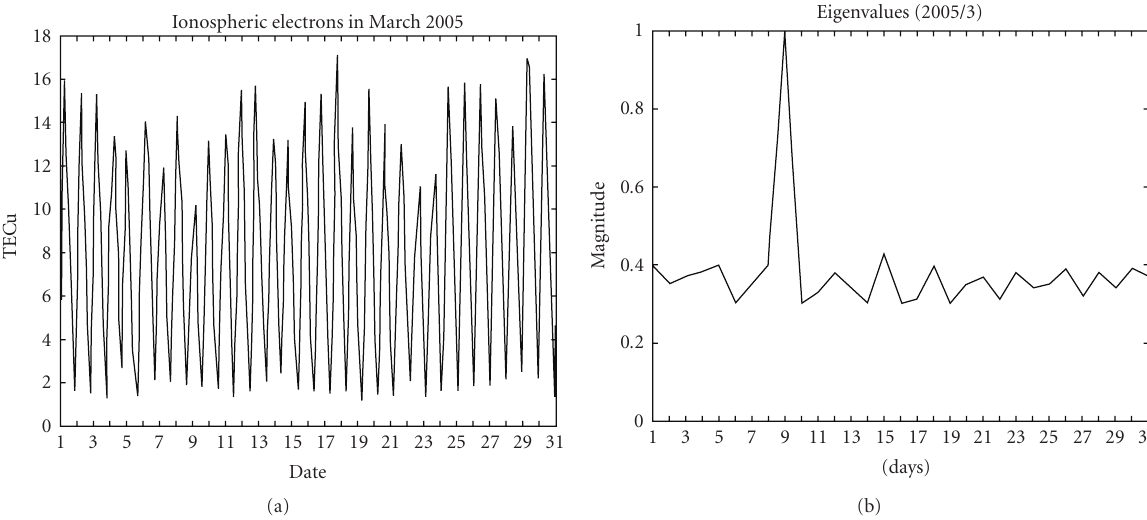
Figure 6: (a) shows the TEC record in May 2005 (Unit: TECu) corresponding to the Kyushu earthquake of 20 March, 2005 M = 6.6 in Japan (Table 1) (TEC data of receiver near the epicenter, the receiver position is at 33.70 ◦ N, 129.70 ◦ E). (b) shows the principal eigenvalues using PCA applied to the TEC record. A larger principal eigenvalue is represented on March 09. These should be the anomalies caused by the earthquake on March